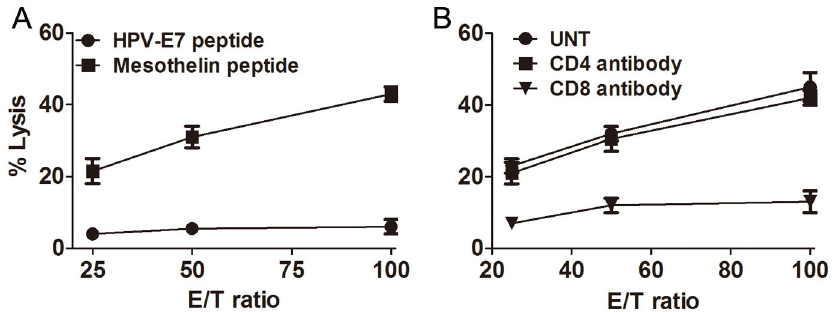
Figure 4. Mice injected with an anti-PD-1/CD137 mAb combination developed a tumor antigen-specific CTL response. Mice (3/group) transplanted i.p. with 3 × 10 6 ID8 cells 10 day earlier were injected i.p. twice at 4 days interval with 0.5 mg of anti-PD-1/CD137 mAb. Seven days after the second mAb injection, pooled splenocytes (5 × 10 6 ) from 3 mice were incubated with 5 × 10 5 UV-irradiated ID8 cells for 4 days. The resultant splenocytes were then evaluated for antigen-specific CTL activity by CytoTox 96 Non-radioactive cytotoxicity assay using EL4 cells pulsed with H-2Db-restricted mesothelin or HPV-E7 peptide as target cells (A). The killing activity was also evaluated in the presence of anti-CD4, anti-CD8 or control antibody (B). Data were expressed